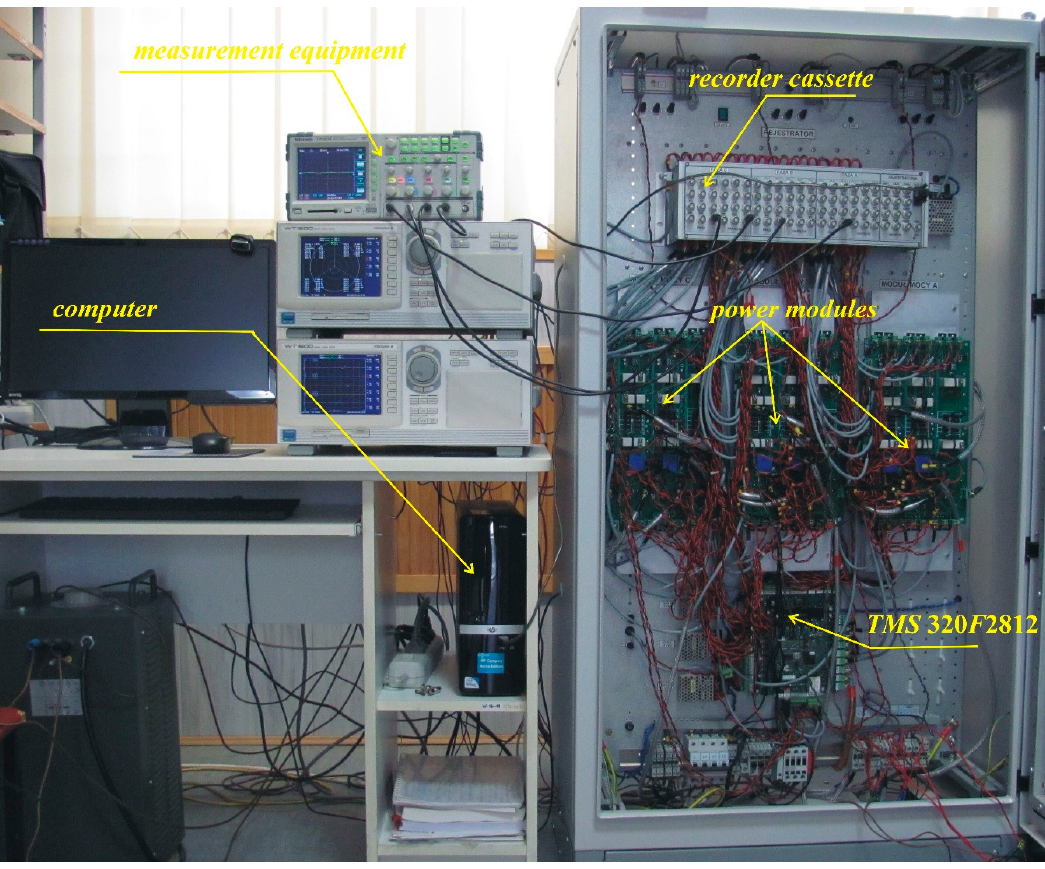
Figure 12. Laboratory station. Table 3. Experimental Parameters.